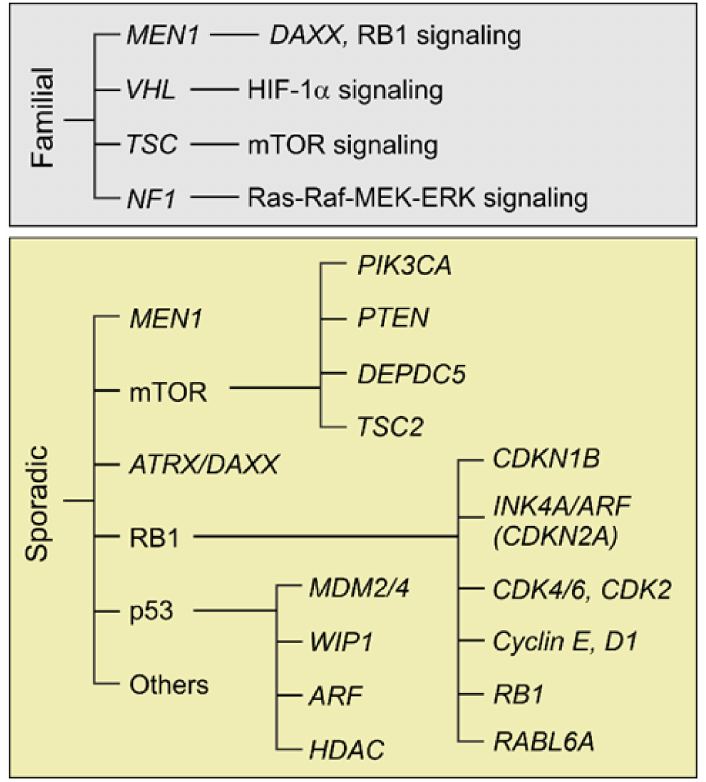
Figure 2. Schematic of frequently altered genes and pathways in familial and sporadic pNETs. Genes (italics) and pathways